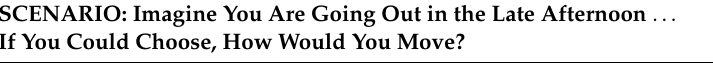
Table 2. Example of a choice